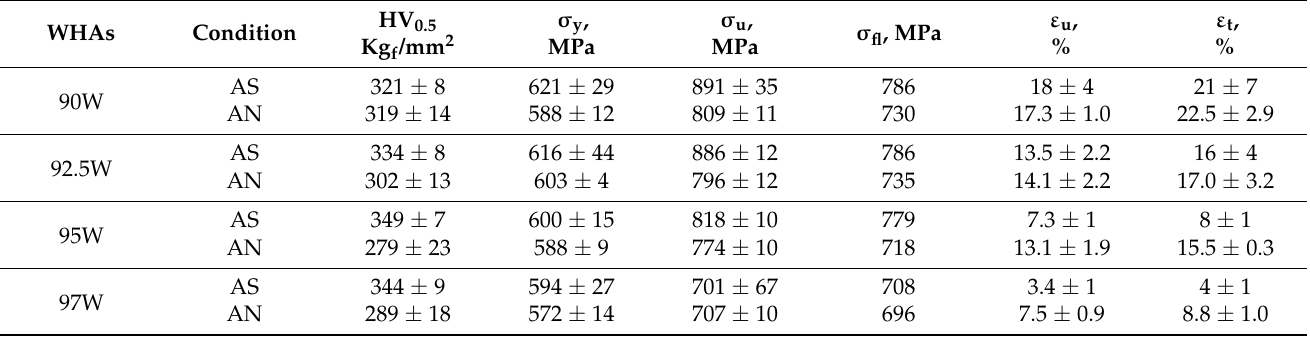
Table 3. RT Vickers microhardness (HV) and tensile properties of 90–97W